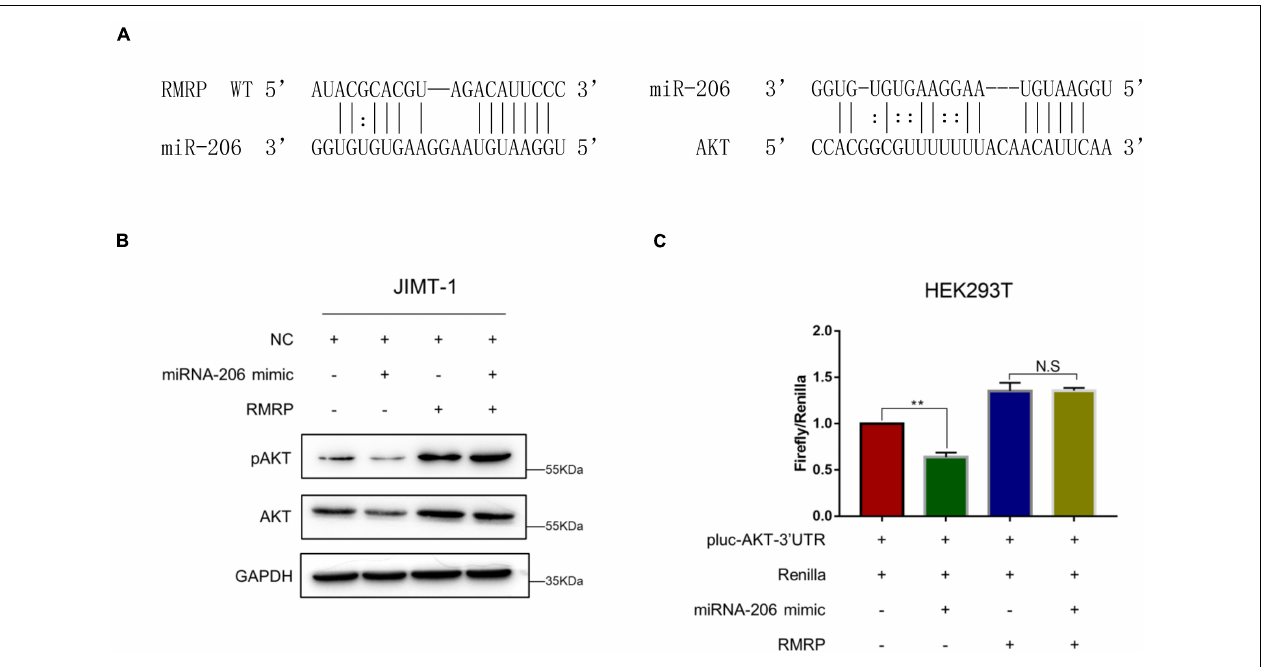
FIGURE 4 | RMRP upregulates AKT expression by sponging miR-206. (A) Both RMRP and AKT are potentially targeted by miR-206 through the miRTarBase. (B) miR-206 mimics-induced inhibition of AKT can be completely restored by RMRP overexpression. (C) The luciferase reporter assay was performed to show that RMRP overexpression completely abrogates miR-206 mimics-induced inhibition of the reporter gene fused with the AKT 3 (cid:48) -UTR. ** p <